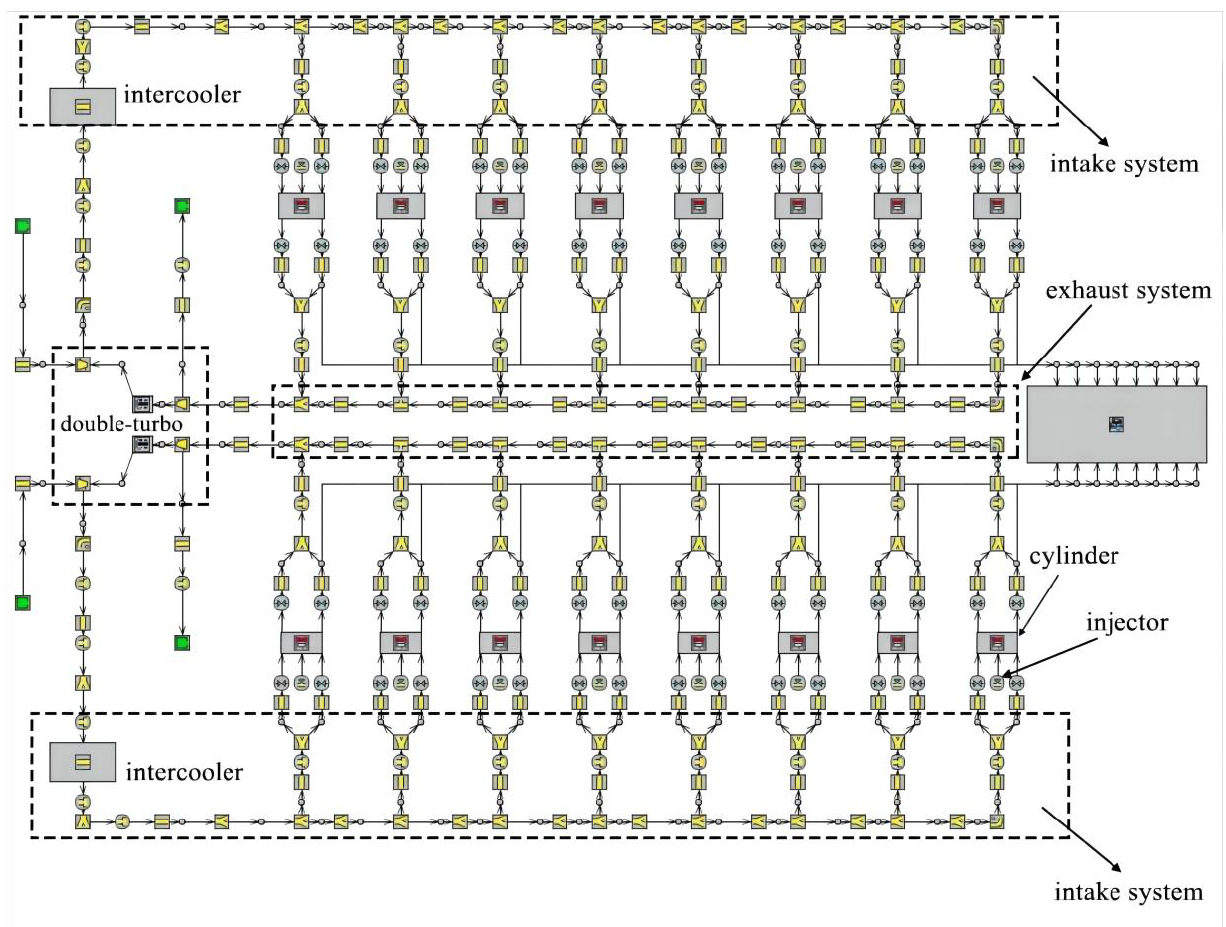
Figure 3. Simulation model of the 16V265H diesel